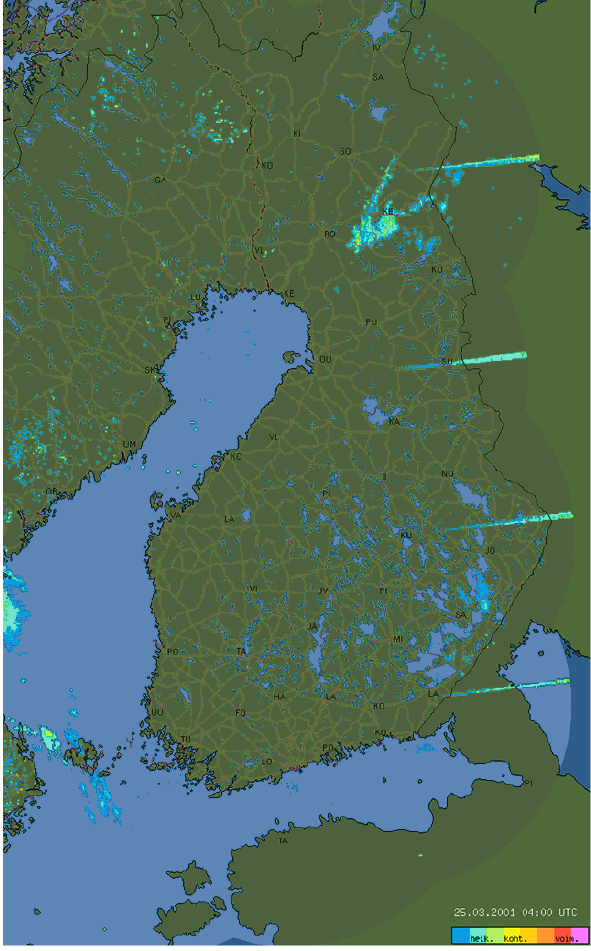
Figure 1. Solar signals observed simultaneously by four radars in Finland on 25 March 2001 at